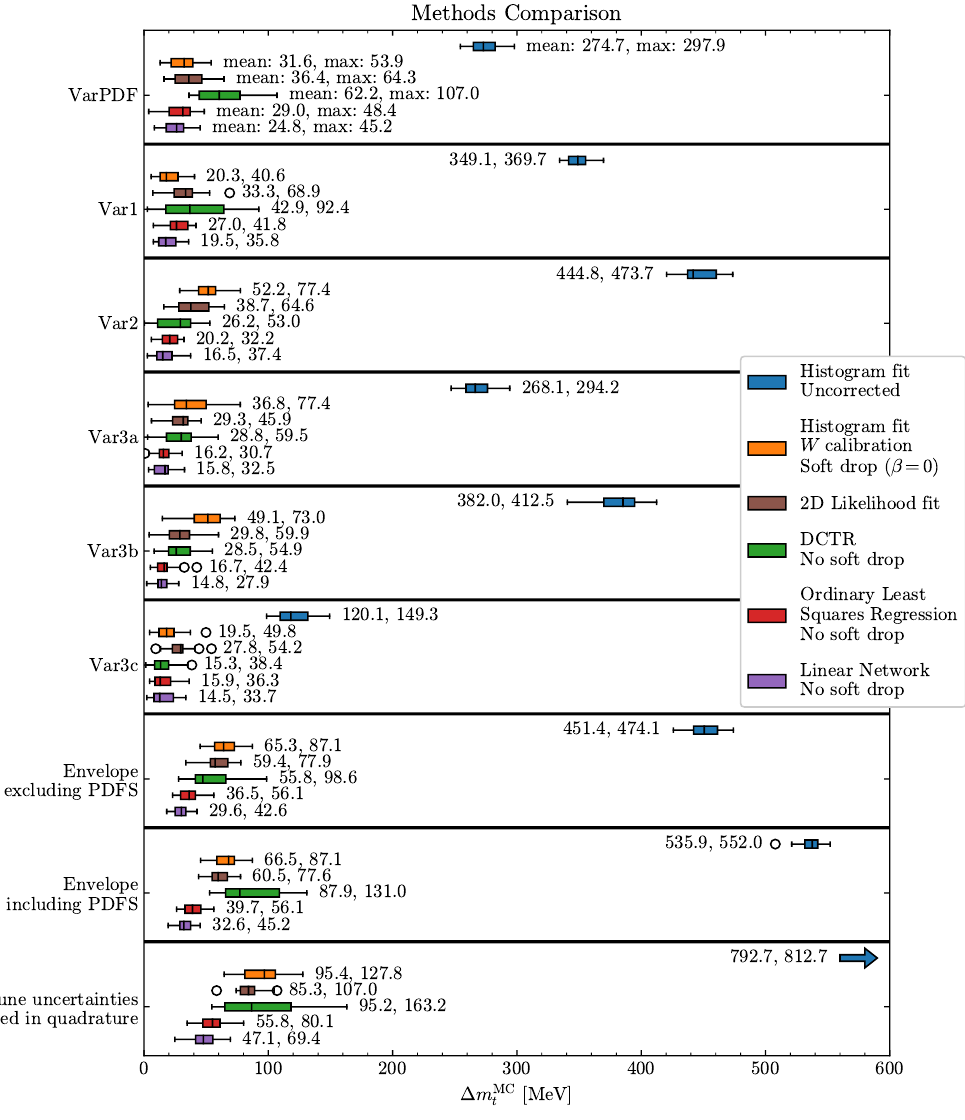
Figure 14. Summary comparison of the different methods. Upper six boxes show top quark tuning uncertainty among six different families of variations. The bottom boxes combine the sepa- rate uncertainties either by taking the envelope over the variations or by adding the uncertainties in quadrature. Here, DCTR uses ParticleFlow to simultaneously extract the mass and the tune parameters, and both the ordinary least squares regression and linear network are trained on en- sembles of re-sampled events. The various methods are discussed more in the